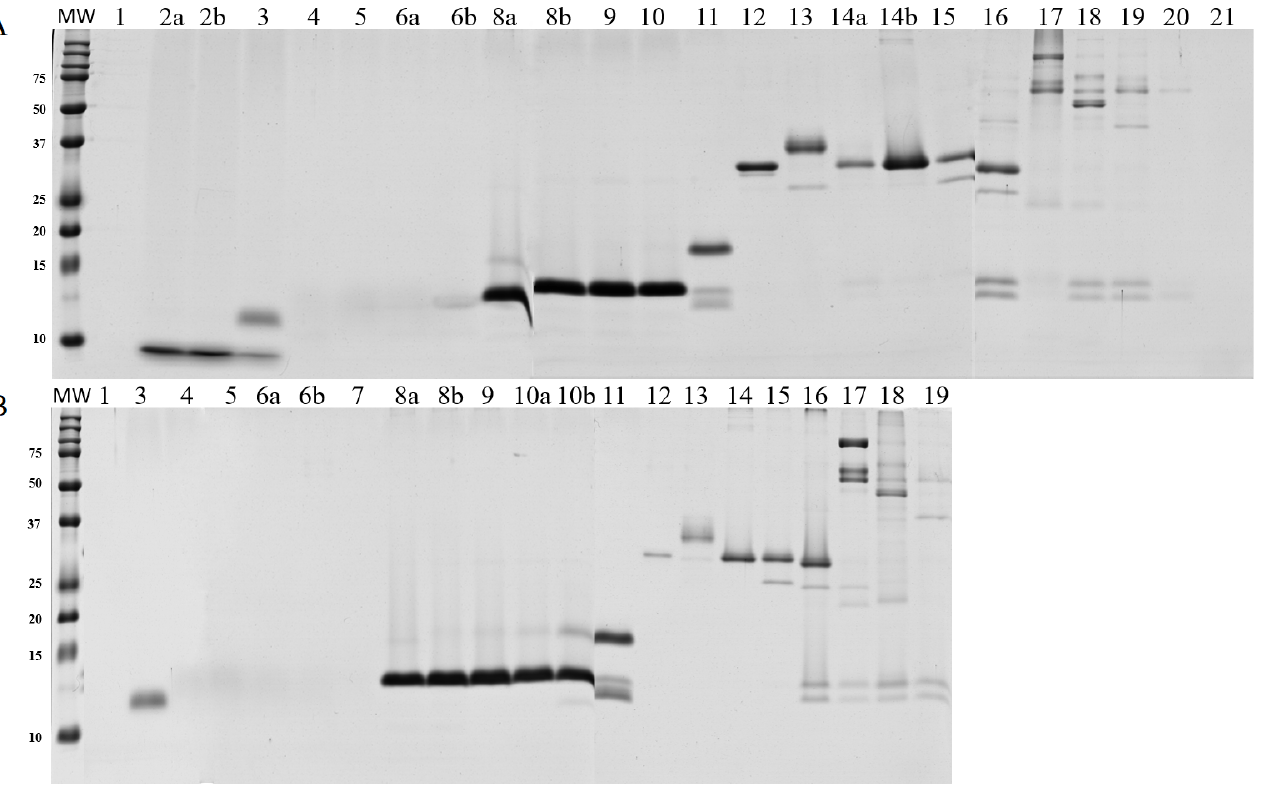
Figure 6. Polyacrylamide gel electrophoresis (15%) of peaks collected by HPLC. The numbers correspond to numbered chromatographic peaks shown in Figure 7. Peaks divided into two aliquots are represented by letters “a” and “b”. MW: molecular weight marker (Dual Color Precision Plus Protein Standards – BioRad); upper panel: crotamine-positive venom pool (+); bottom panel: crotamine-negative venom pool (–).